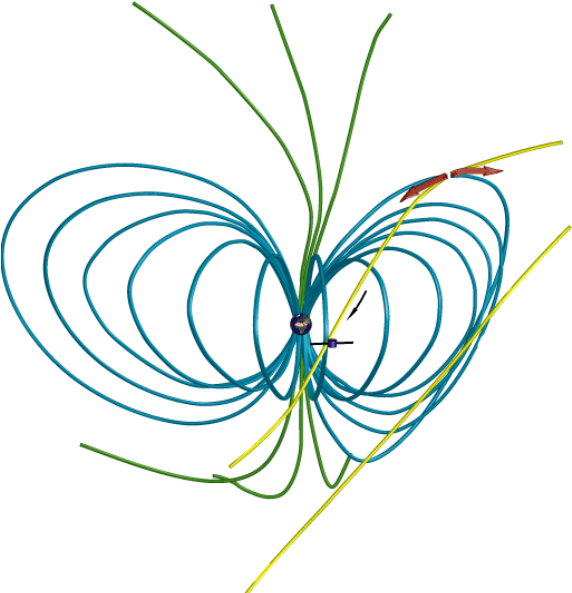
Fig. 4. Schematic diagram of the magnetic configuration and the location of Geotail (at the dayside equatorial plane). Green, blue, and yellow lines indicate open, closed, and interplanetary magnetic field lines, respectively. Maroon arrows display reconnection jets (field line motions), while a black arrow shows the anti-field aligned flow of energetic ions observed by Geotail.